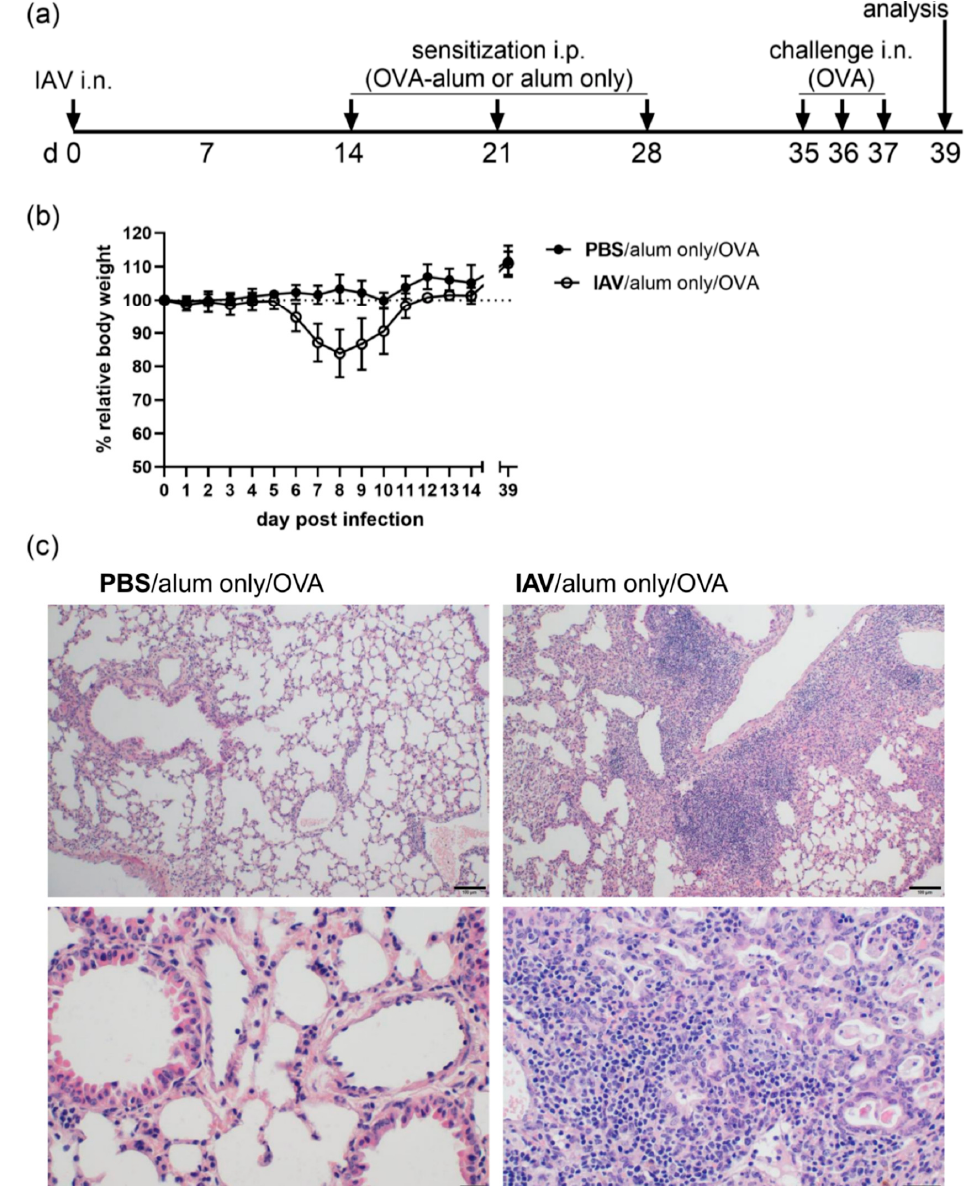
Figure 1. IAV (influenza A virus) infection leads to persistent histological changes in the lung. ( a ) Mice were infected i.n. with a sublethal dose of IAV or treated with PBS on day 0, were mock-sensitized (alum only i.p.; days 14, 21, 28) and treated i.n. with OVA (days 35, 36, 37). ( b ) Body weight was monitored daily following the infection. Relative body weights are shown as the mean ± SD of n = 19 controls (PBS / alum only / OVA) and n = 23 IAV infected mice (IAV / alum only / OVA) for days 0 to 14 and day 39 compiled from five experiments. ( c ) On day 39 post infection, mice were sacrificed and lung tissue was histologically analyzed. Representative images are shown for one out of 4 controls (PBS / alum only / OVA) and one out of 5 infected mice (IAV / alum only / OVA) analyzed. The upper images were prepared at 100× magnification (scale bar 100 µm), the lower images at 400× magnification (scale bar 20 µm).